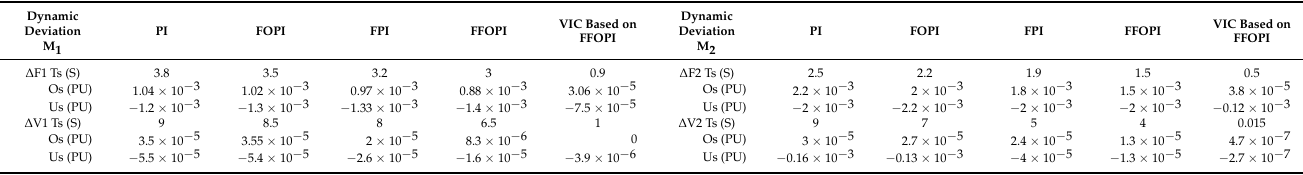
Figure 12. Interconnected microgrid’s frequency and voltage measurements versus time for each controller at wind speed disturbance: ( a ) ∆ F 1 (P.U), ∆ F 2 (P.U), ( b ) ∆ V 1 (P.U), ∆ V 2 (P.U). The dynamic specification (settling time (Ts), overshoot (Os), and undershoot (Us)) of frequencies and voltage deviation at each controller can be summarized in Table 10. Table 10. Dynamic specification of frequencies and voltage deviation for each controller at wind speed